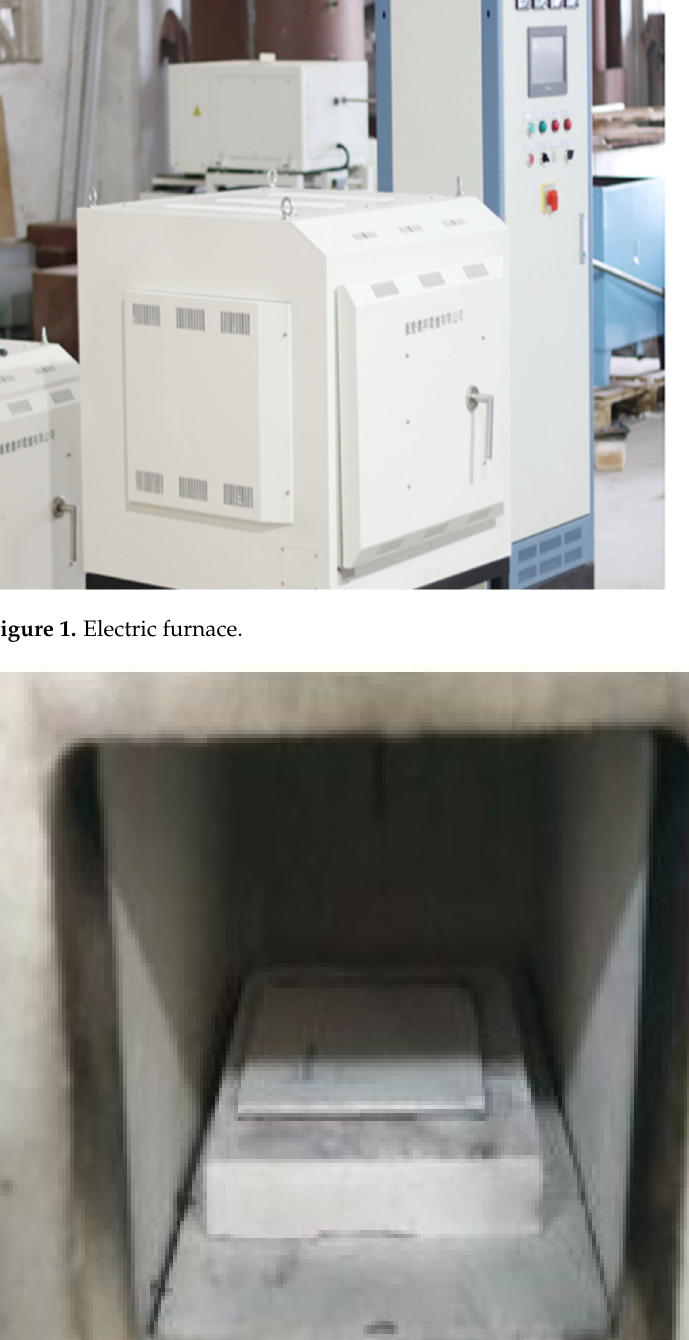
Figure 2. Specimen in the furnace.